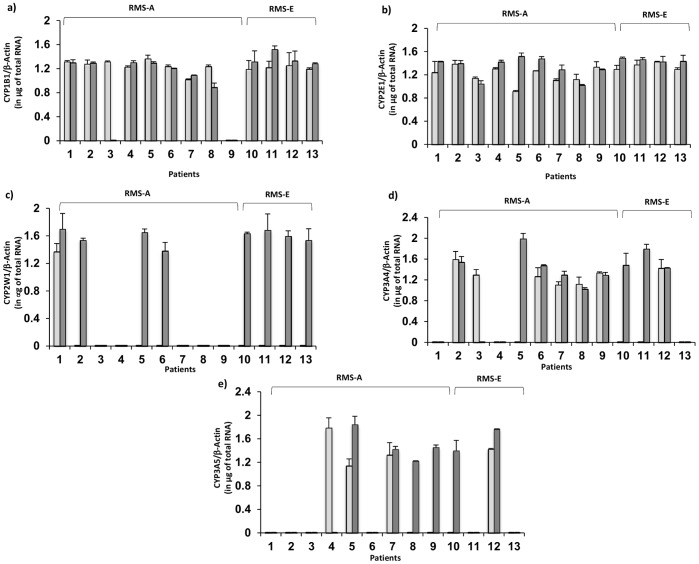
Levels of normalized mRNA Expression of (a) CYP1B1, (b) CYP2E1, (c) CYP2W1, (d) CYP3A4 and (e) CYP3A5 in 13 pairs of tumor and corresponding normal adjacent tissue from patients with RMS.Transcript levels of each CYP gene were normalized to β-actin and expressed per μg of total RNA. Values represent means and average of standard deviations of expression levels determined in triplicate. *p<0.05.